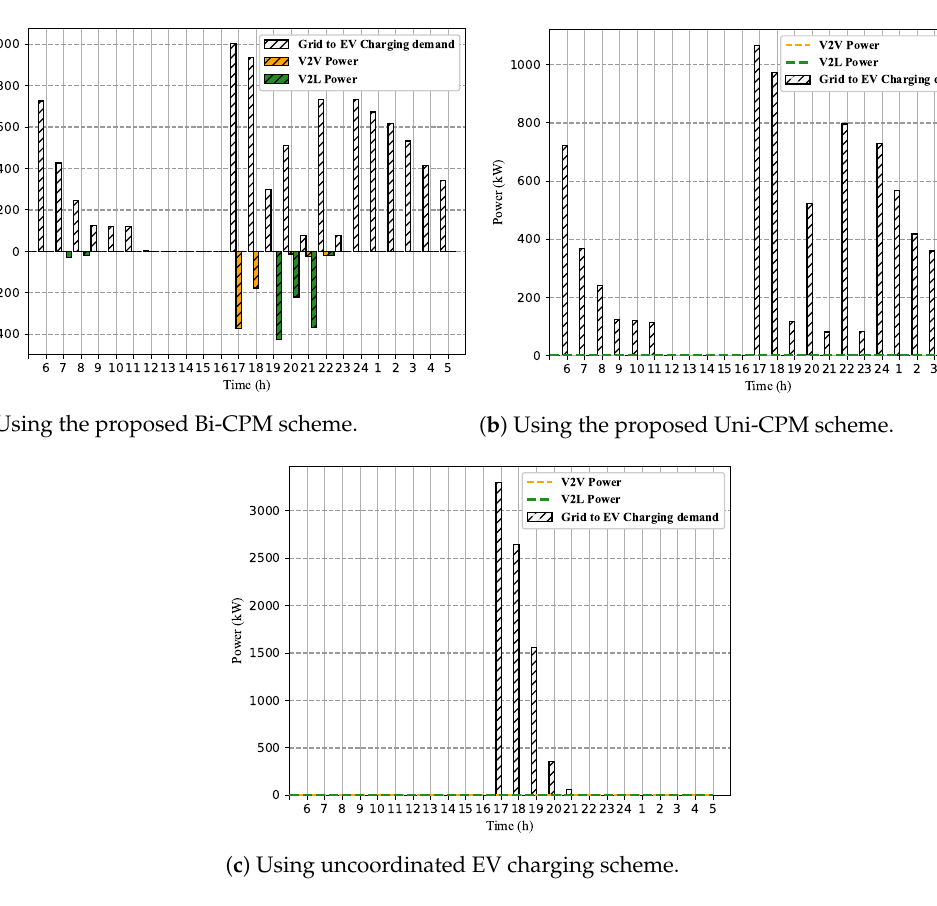
Figure 6. Obtained profiles in